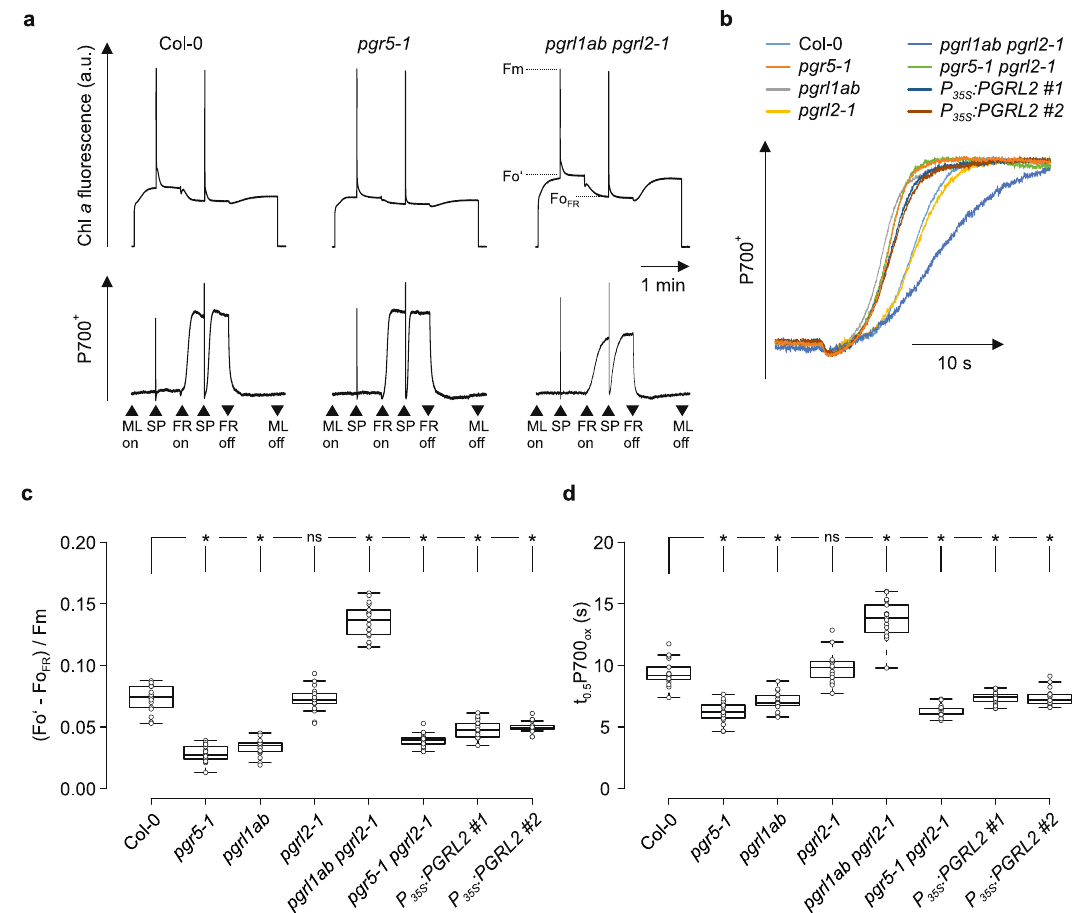
Fig. 4 Plastoquinone reduction and PSI electron transport are altered in the absence of PGRL1 and PGRL2 under very low light. a Chl a fl uorescence and P700 oxidation kinetics were recorded simultaneously with a Dual-PAM system as described 27 . After switching on measuring light (ML, 1 µ mol photons m − 2 s − 1 ) and applying an initial saturating pulse (SP), leaves adapted to dark for 1 h before were exposed to far-red light (FR) for 60 s. The FR light treatment was interrupted by a second SP after 30 s. b Excerpt from the P700 oxidation kinetics during FR exposure. Graphs were normalized to the minimal and maximal P700 + levels which were recorded in between the fi rst and second SP. c Quanti fi cation of the Chl a fl uorescence drop shortly after FR treatment. The difference of the Chl a fl uorescence ground state in ML (Fo ’ ) and the minimal Chl a fl uorescence level (Fo FR ) during FR treatment was normalized to the maximal Chl fl uorescence (Fm). d Quanti fi cation of P700 + oxidation half time t 0.5 P700 ox after FR light exposure. Seventeen replicates for every genotype were measured. The horizontal lines in c , d represent the median, and boxes indicate the 25th and 75th percentiles. Whiskers extend 1.5× the interquartile range, outliers are represented as dots. For statistical analyses in ( c , d ), the non-parametric Kruskal – Wallis test was performed, followed by pairwise Dunn ’ s tests. The p -values were adjusted on an experiment level using the Benjamini – Hochberg method. Statistically signi fi cant differences are marked with asterisks (* p ≤ 0.05, ns, not statistically signi fi cant). P -values in c (order as displayed): 6.5 × 10 − 10 , 5.2 × 10 − 8 , 0.5, 0.04, 8.1 × 10 − 6 , 5.1 × 10 − 3 and 1.2 × 10 − 2 . P -values in d (order as displayed): 1.0 × 10 − 7 , 2.9 × 10 − 4 , 0.4, 0.03, 3.6 × 10 − 8 , 3.5 × 10 − 3 and 2.8 × 10 − 3